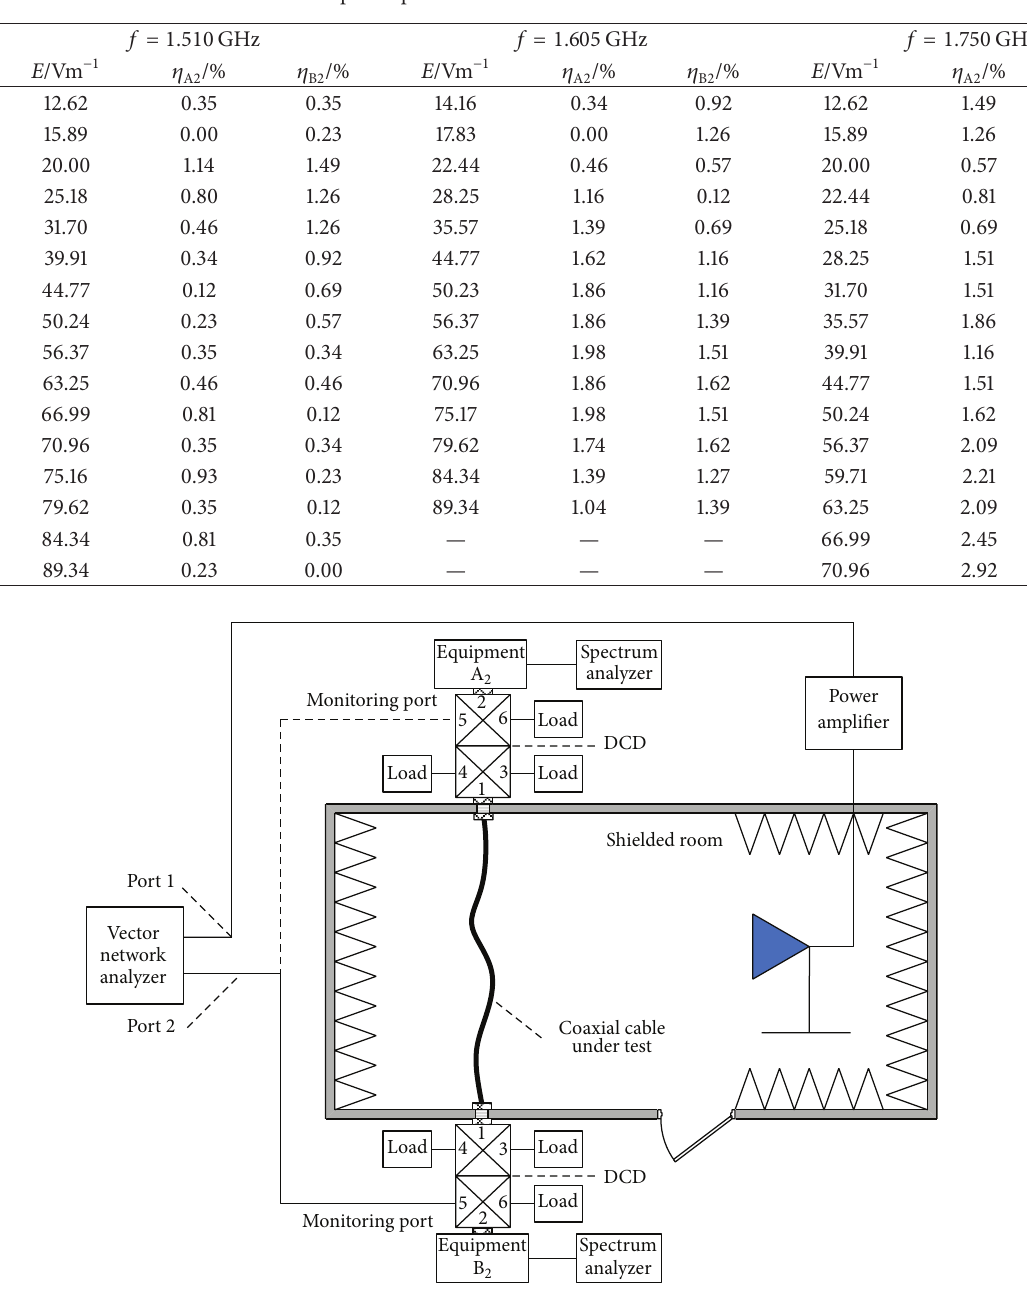
Table 2: Output response relative error for DDMCI test method.